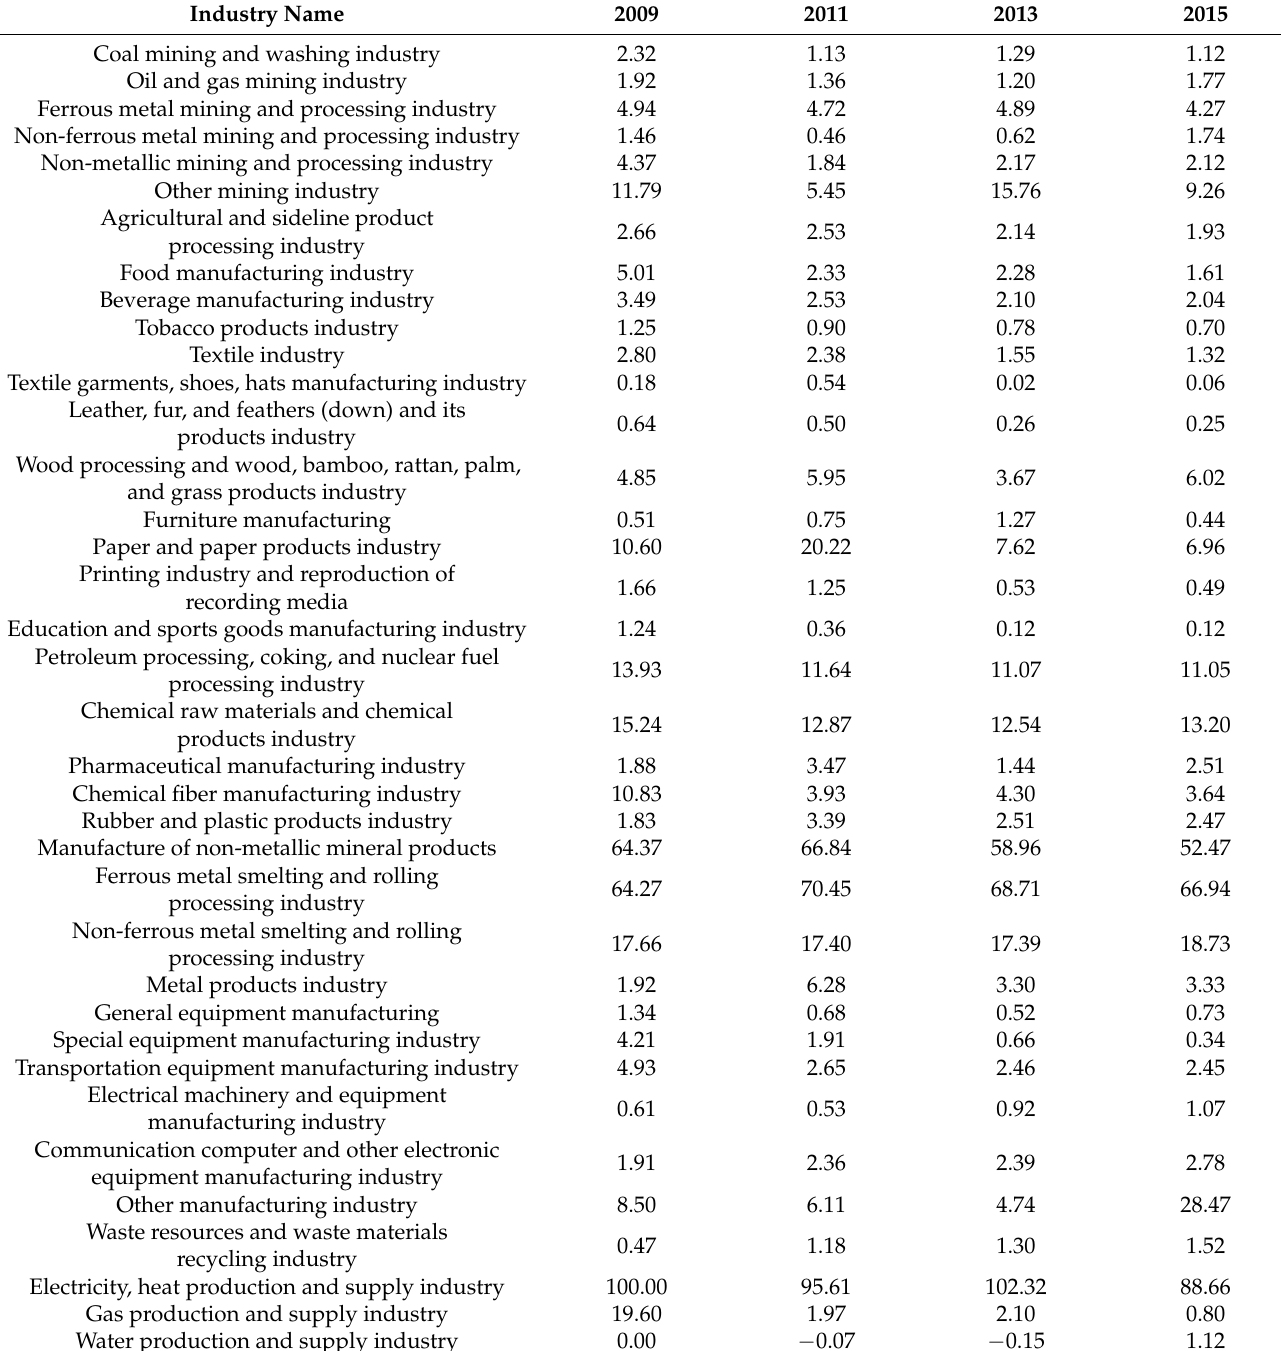
Table 1. Haze pollution index of each industry in